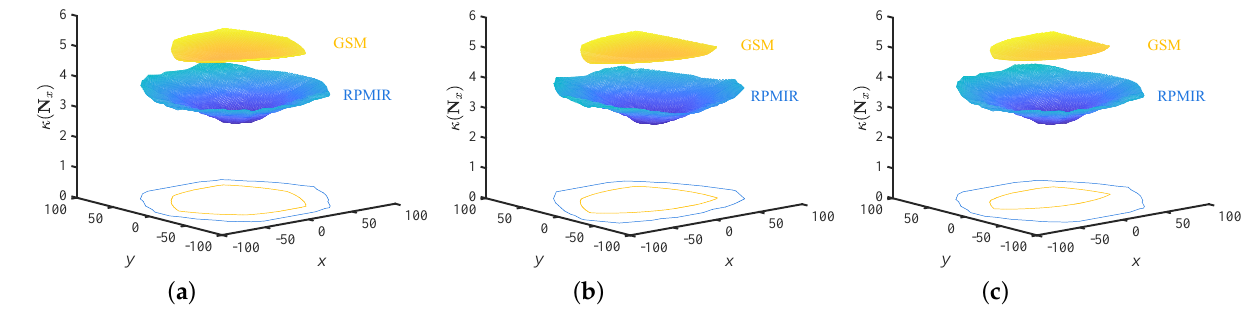
Figure 8. The condition number distributions of the RPRI and the GSM with O (cid:48) under different orientations. ( a ) Torsion and tilt angles = 0 ◦ . ( b ) Torsion and tilt angles = 5 ◦ . ( c ) Torsion and tilt angles = 10 ◦ .